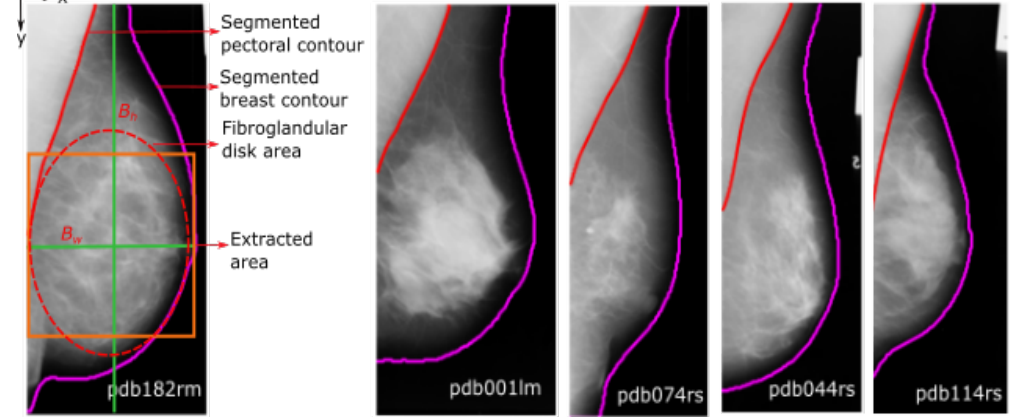
Figure 3. Example of segmentation results using our method in